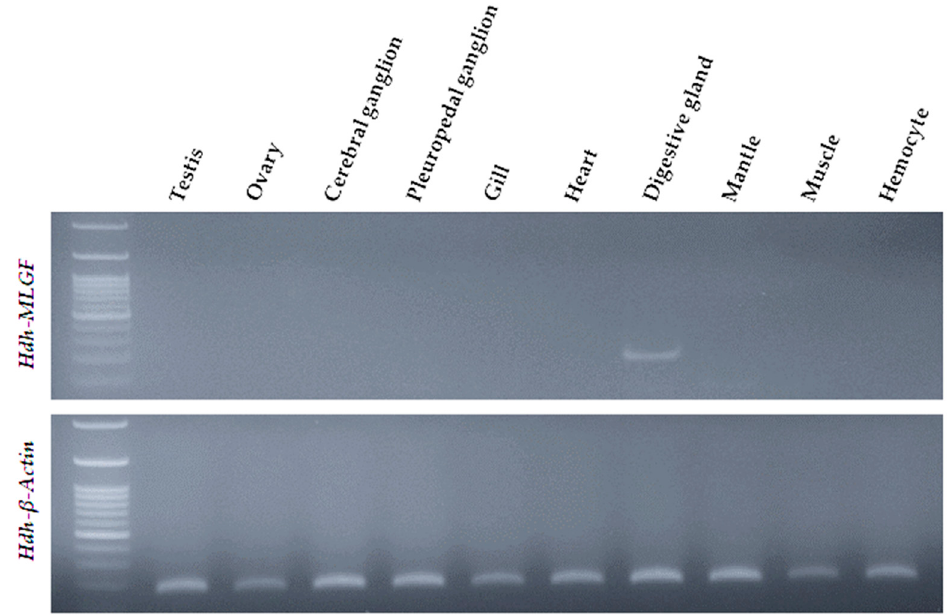
Figure 8. Tissue specific distribution of Hdh-MLGF and Hdh- β -Actin in the Pacific aba- lone, H. discus hannai.